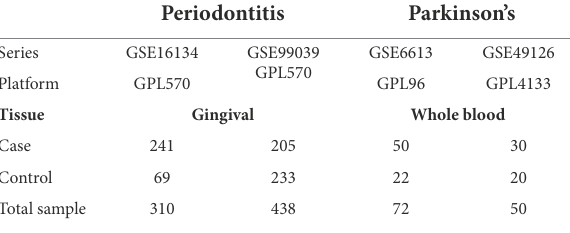
TABLE 1 Datasets of periodontitis and Parkinson’s